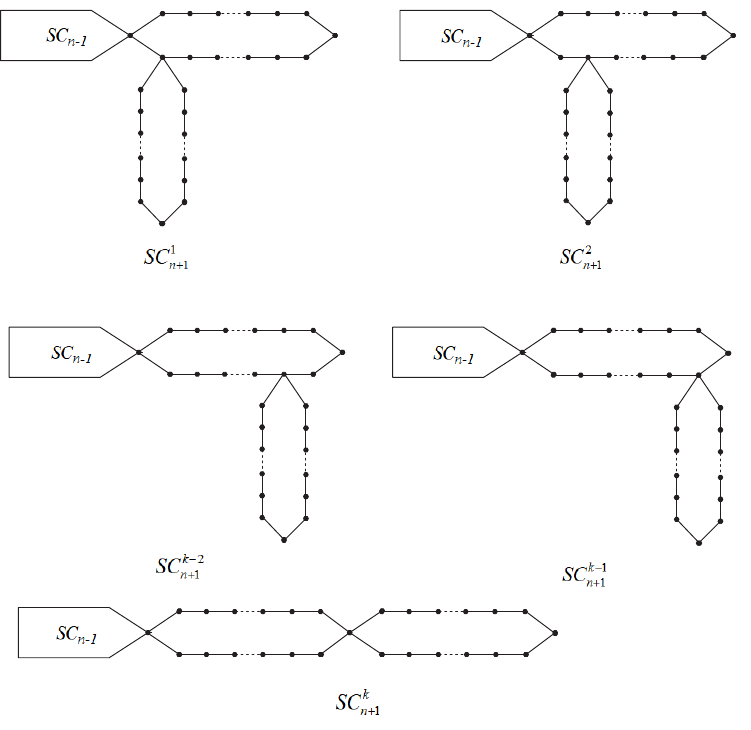
Figure 2. The k types of partial arrangements in regular polygonal